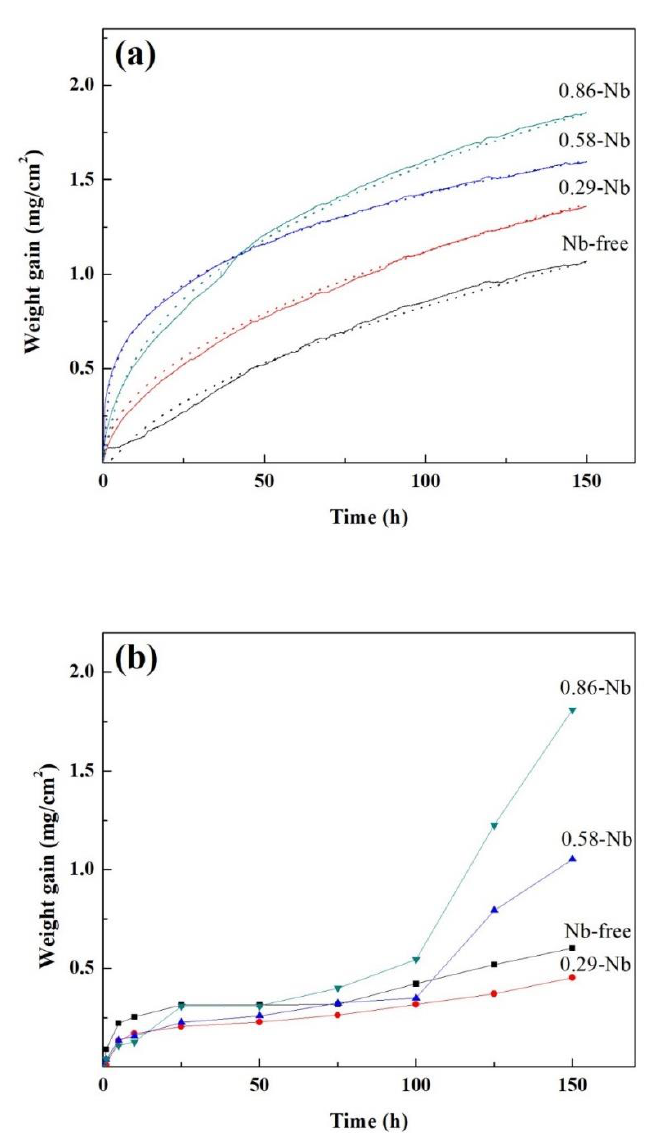
Figure 2. Weight change per unit area as a function of time in 22Cr25NiWCoCu stainless steels with 0–0.86% Nb for continuous and discontinuous measurements in ( a ) thermal gravimetric analysis (TGA) and ( b ) an atmospheric box furnace, respectively.